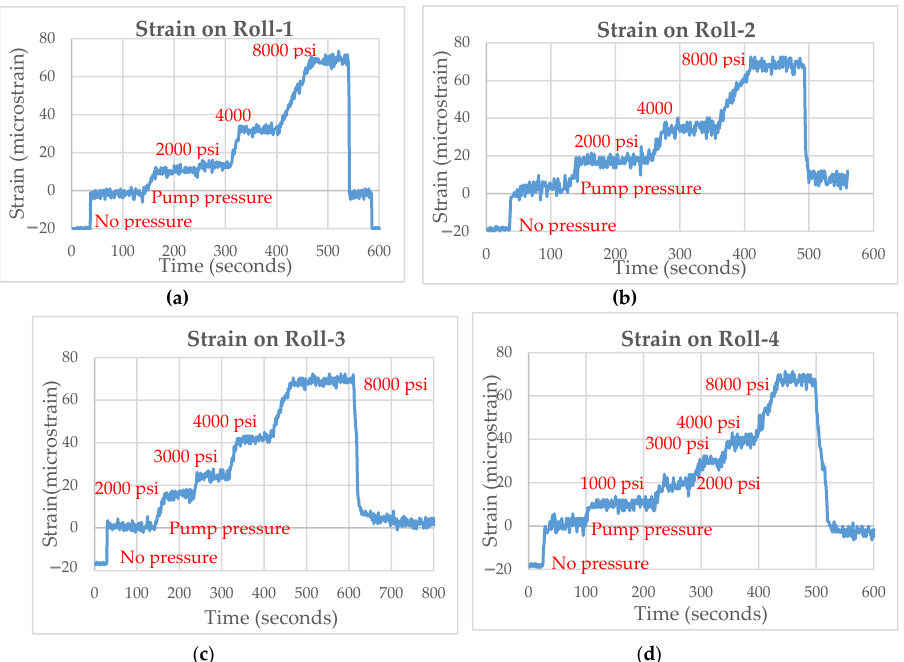
Figure 10. ( a ) Strains measured at Roll-1 for varying loads. ( b ) Strain measured by Roll-2 for varying loads, ( c ) Strain measured by Roll-3 for varying loads, ( d ) Strain measured by Roll-4 for varying loads.